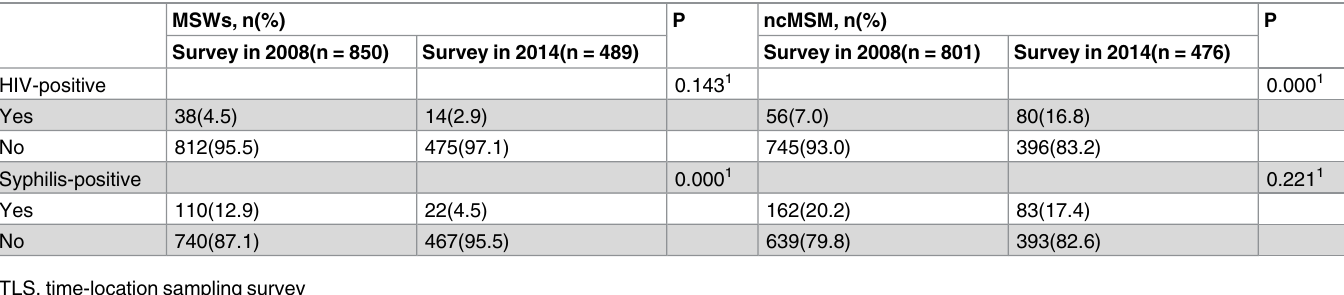
Table 2. A comparison with the data from the previous